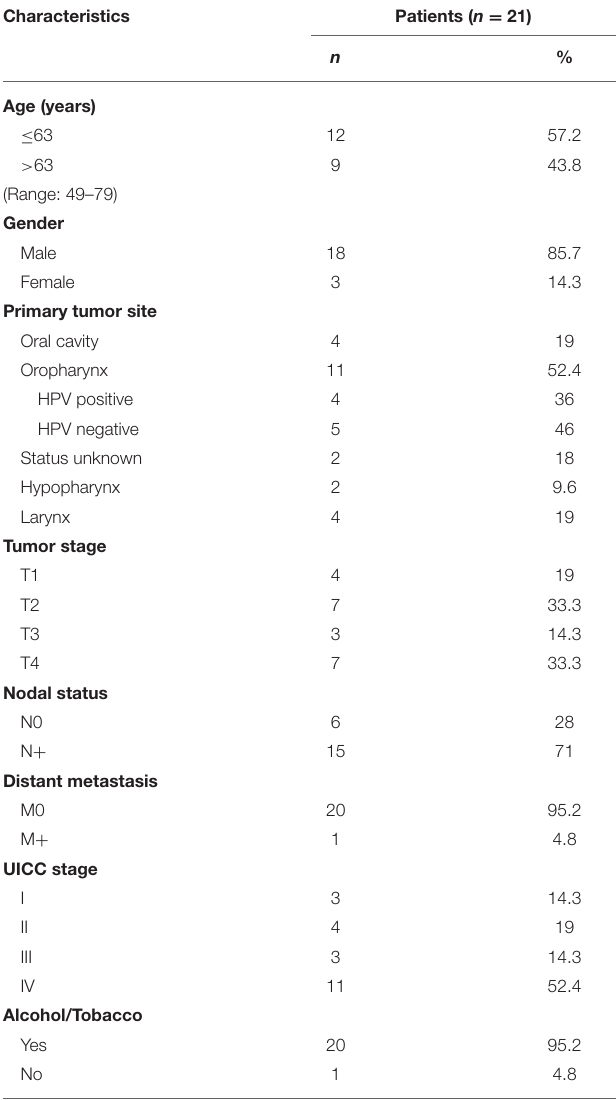
TABLE 1 | Clinicopathological data of HNSCC patients enrolled in this study. Characteristics